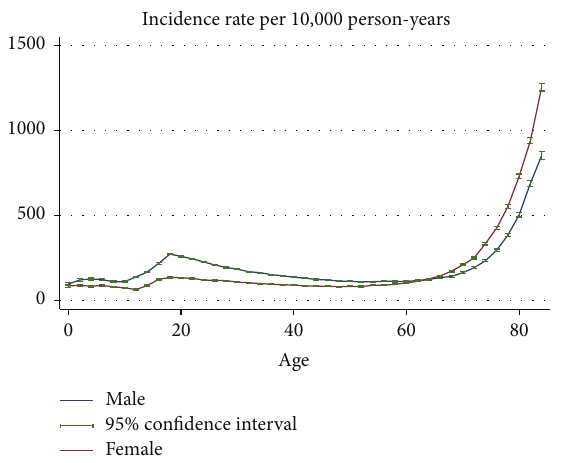
Figure 6: Gender-age-specific overall injury hospitalisations